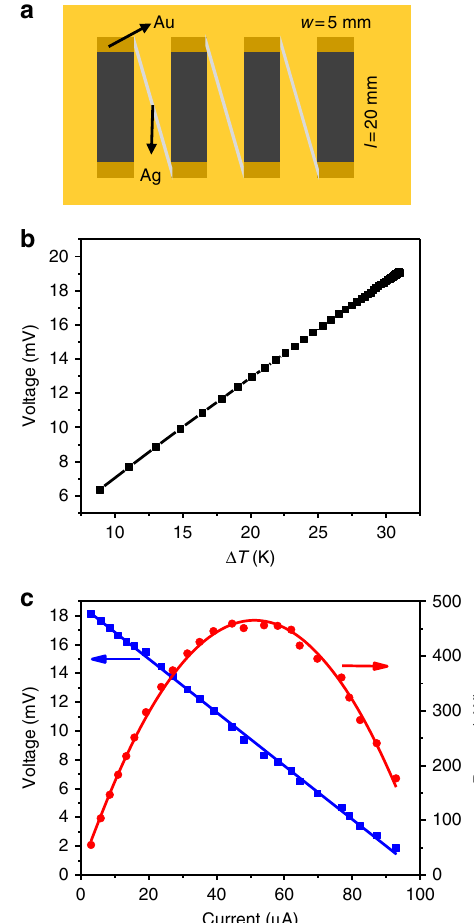
Fig. 4 Schematic illustration and performance of the prepared device. a The schematic illustration of the TE device. b The open-circuit voltage at various temperature difference. c The output voltage and output power versus current at temperature difference of 30